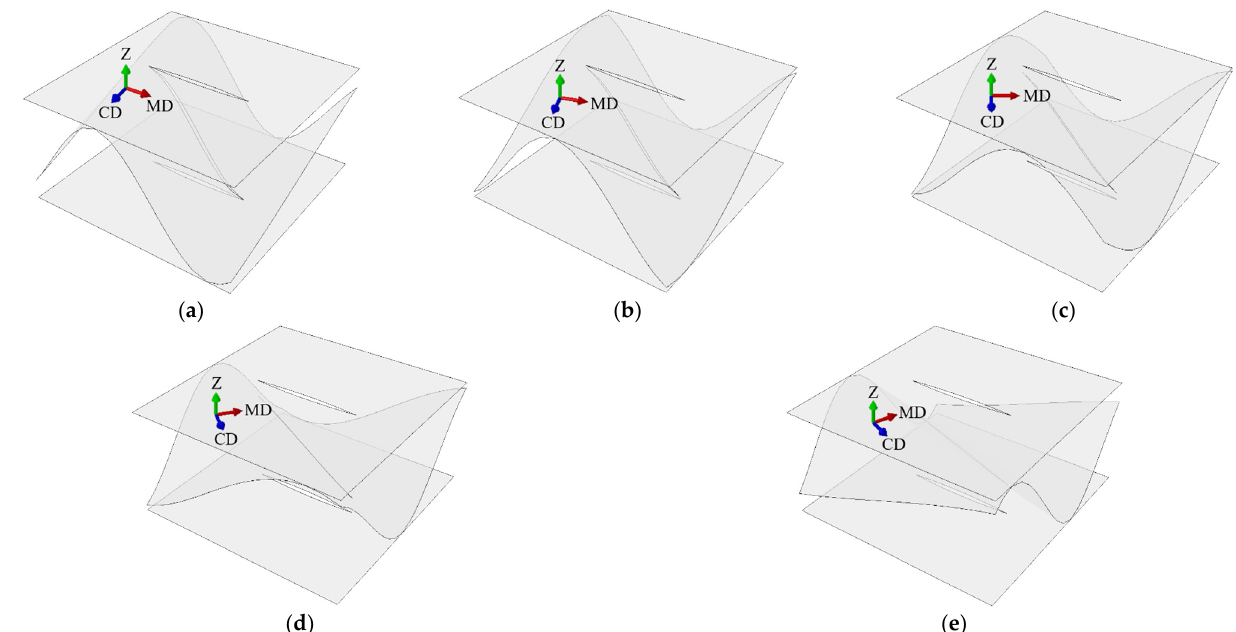
Figure 6. Perforation orientation in sample SW-44-F: ( a ) rotation by 15 degrees; ( b ) rotation by 30 degrees; ( c ) rotation by 45 degrees; ( d ) rotation by 60 degrees; ( e ) rotation by 75 degrees.